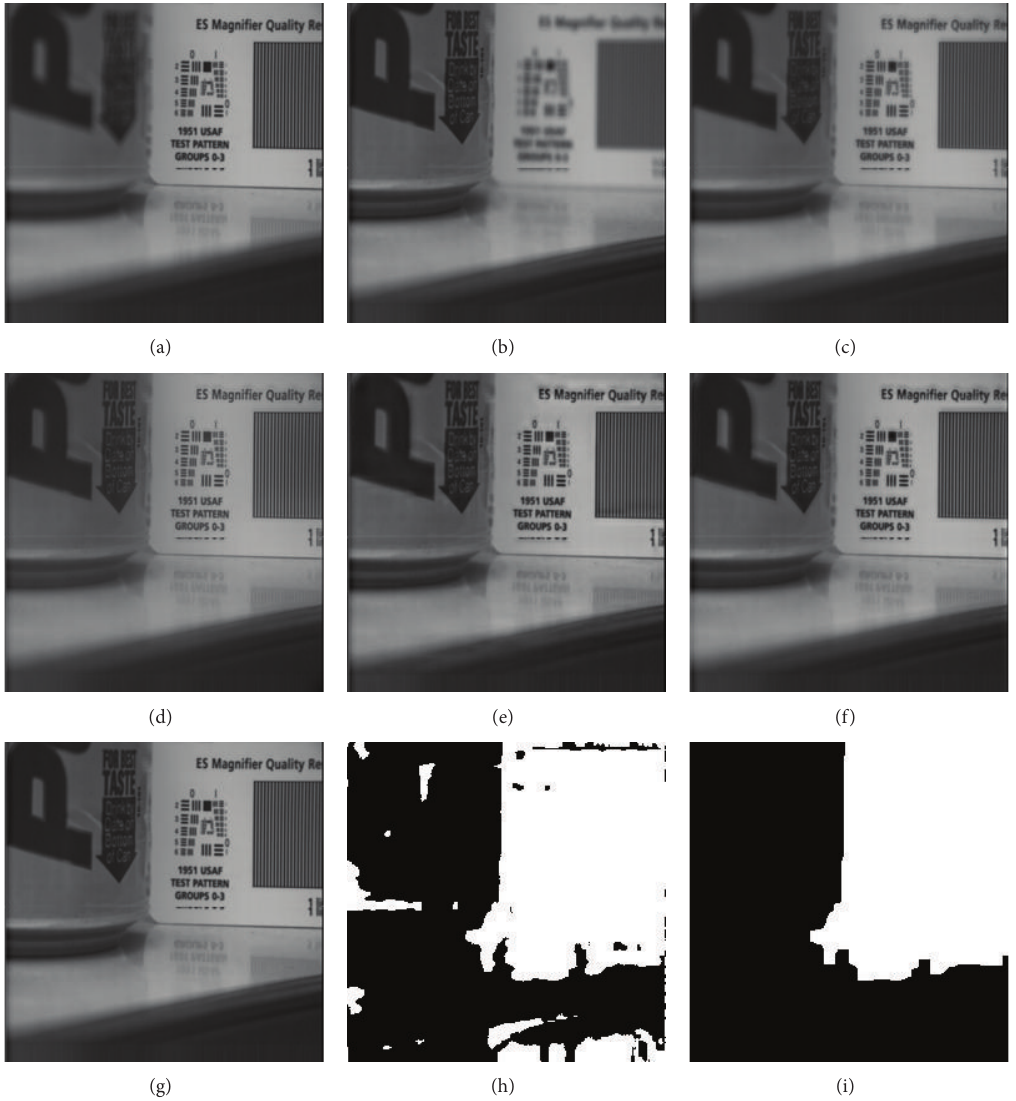
Figure 5: Original and fused image of “pepsi”: (a) focus on the right; (b) focus on the left; (c) fused image using average; (d) fused image using gradient pyramid; (e) fused image using DWT; (f) fused image using SIDWT; (g) fused image using the proposed method; (h) the initial focused region; (i) the modified focused